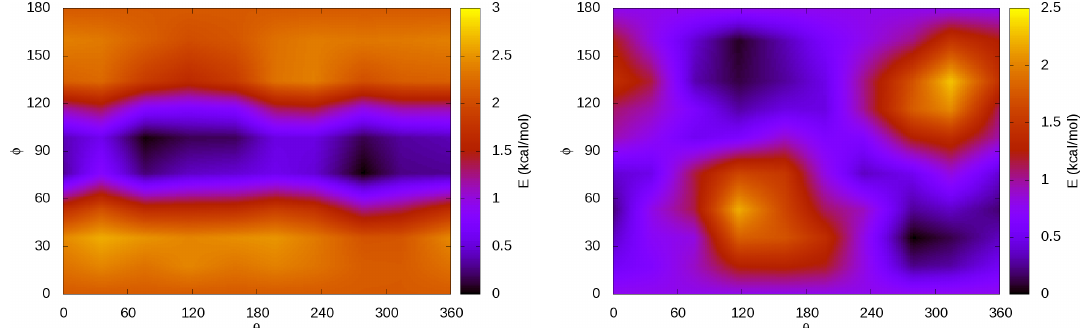
Figure 4. Energy map for the H cage ( left ) and the P cage ( right ). φ is the angle with respect to the c -axis and θ is the angle with respect to the a -axis. Darker colors correspond to more stable orientations.